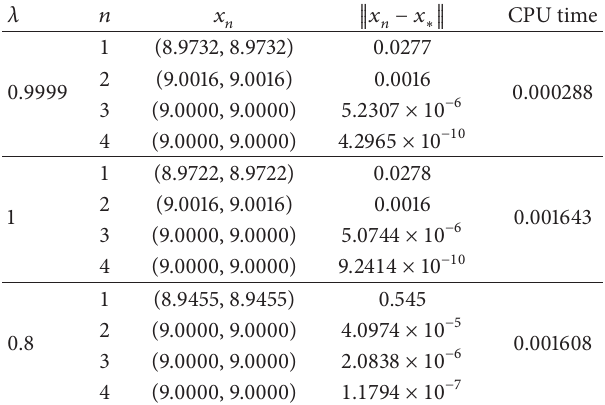
Table 3: Relaxed secant method with different 𝜆 . Table 4: Numerical results for nonlinear conservative systems.